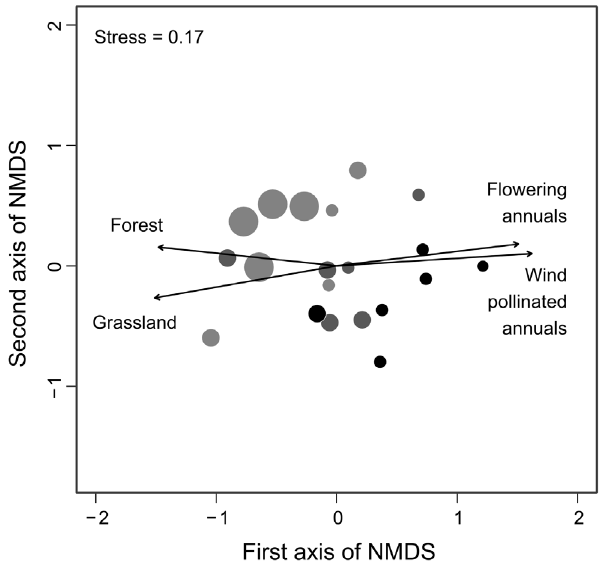
Figure 2. Ordination of bee communities with landscape variables. Ordination of bee community composition using non- metric multidimensional scaling (NMDS) shows that communities change as the proportion of grassland and forest cover increase in a 1500 m radius surrounding sites (stress =0.17). Sites with negative NMDS axis one scores are correlated with grassland (R 2 =0.46, P =0.0054) and forest (R 2 =0.43, P =0.0071), while sites with positive NMDS axis one scores are correlated with wind pollinated crops (R 2 =0.52, P =0.0025) and flowering annual crops (R 2 =0.45, P =0.0057). Increasing circle size represents sites with higher bee abundance while decreasing color intensity (black to light gray) indicates sites with higher levels of bee